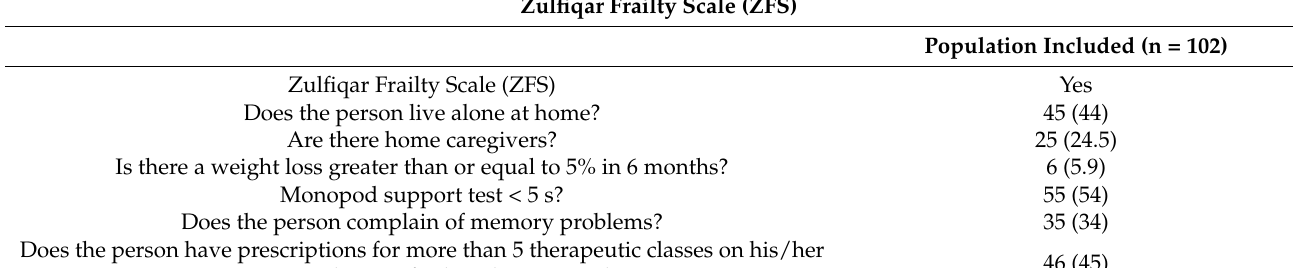
Table 4. Zulfiqar Frailty Scale (ZFS).